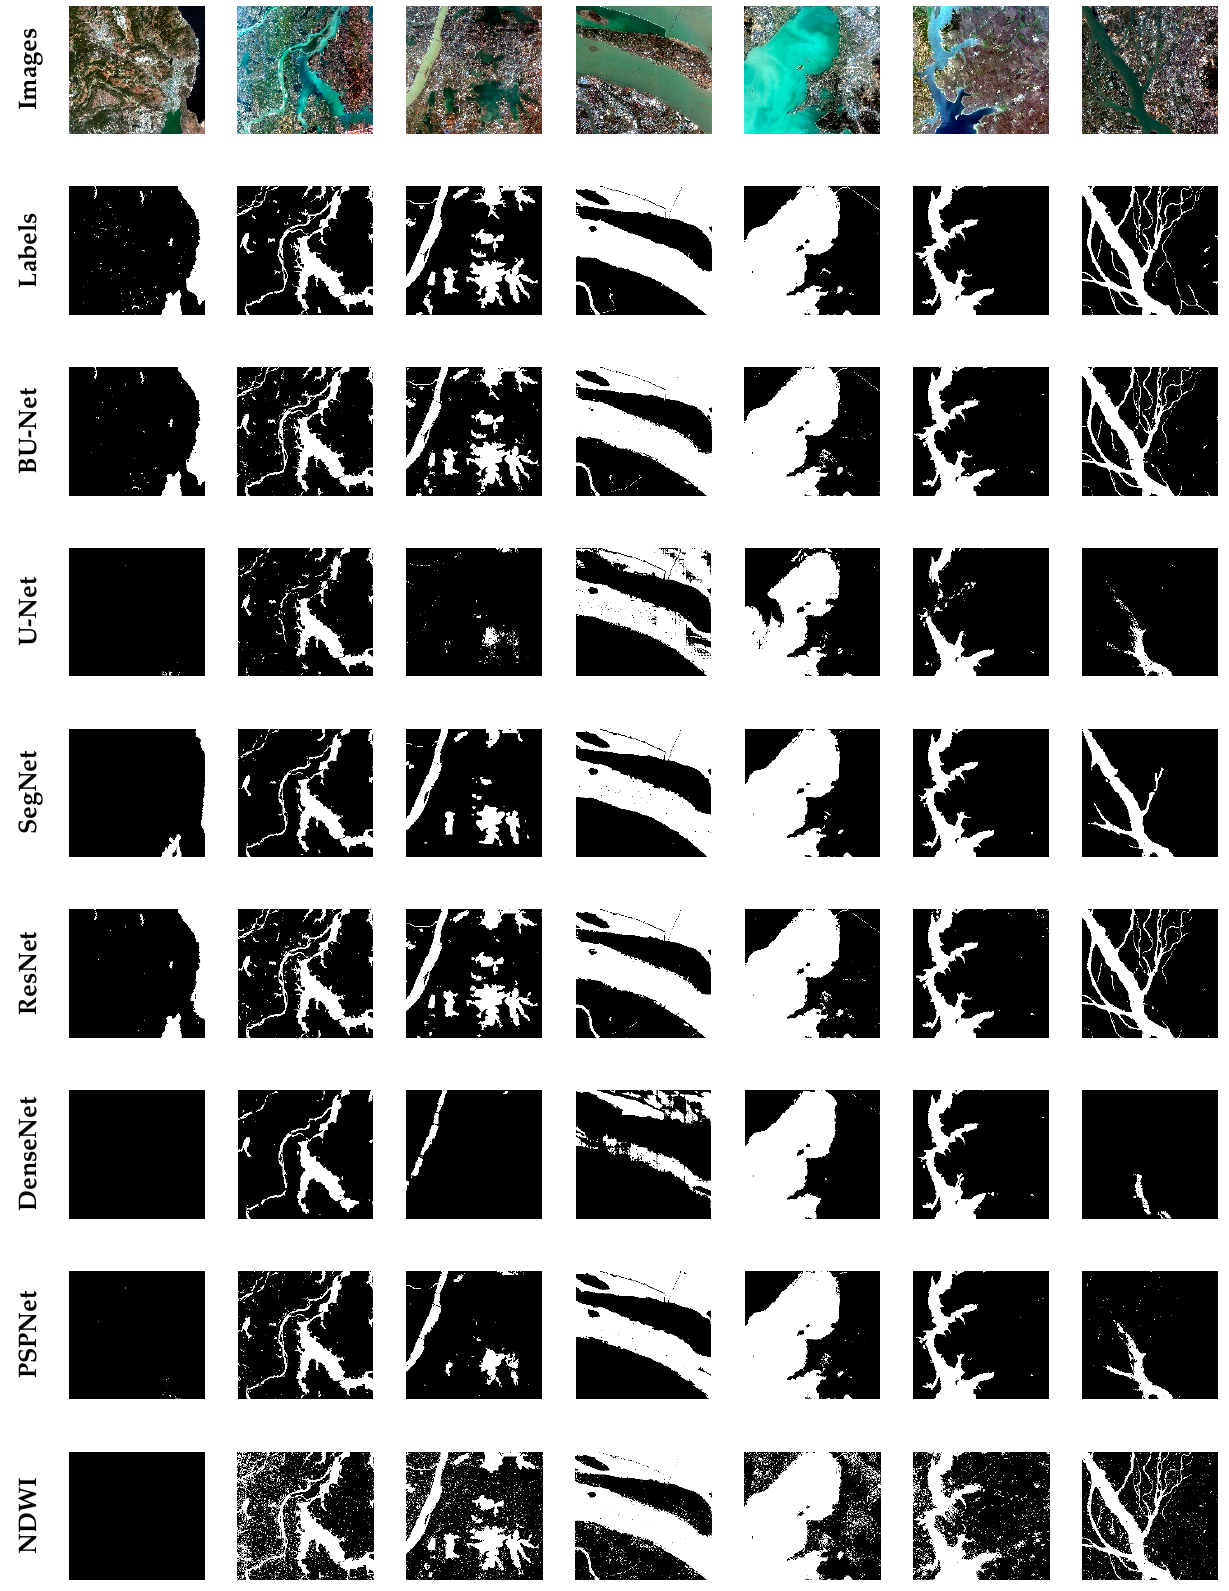
Figure 6. Prediction results of different networks.